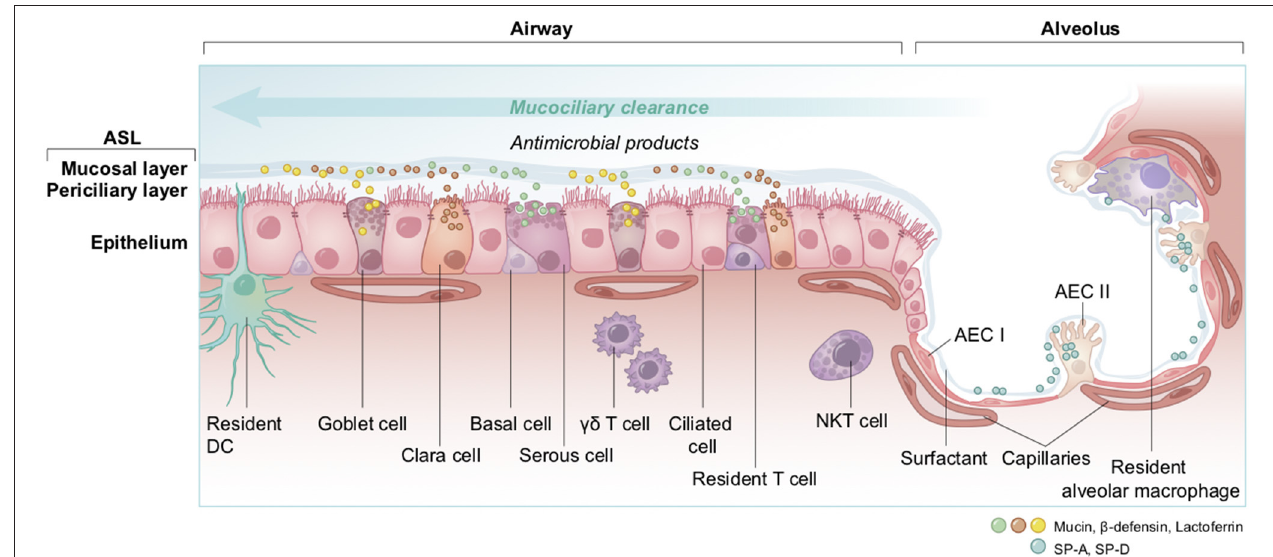
FIGURE 13 | Overview of cell types and innate immunity in the epithelium of the lung. The airway epithelium is a pseudostratified columnar epithelium involved in air conduction, lung moisture and protection. It lines the respiratory airways and is made up of different cell types. Basal cells serve as progenitor for other cells; goblet and serous cells produce and secrete antimicrobials and mucins as part of the airway surface liquid (ASL, composed of a periciliary layer and a more viscous upper mucosal layer); clara cells, with short microvilli, secrete defensive surfactants; and ciliated cells which act in mucociliary clearance. At the endpoint of the respiratory system, the alveolar epithelium that lines alveoli is a thin simple squamous epithelium made up of two cell types; AEC I are flattened squamous cells covering 95% of the surface, in close interaction with the capillaries to facilitate gas exchanges; and AEC II which are cuboidal cells producing and secreting the surfactants. Additionally, to ensure the host protection, many immune cells are resident; the DC, with their snorkels-shaped extension across epithelial tight junctions act as phagocytes and antigen presenting cells in contact with antigens; T cells, γδ T, and NKT cells are characterized by a rapid production and secretion of cytokines upon interactions with pathogens; and alveolar macrophages which are sentinel phagocytes in close proximity with AEC I and II in the alveoli. DC, dendritic cell; NKT, natural killer T cell; γδ T, gamma delta T cell; AEC I and AEC II, alveolar epithelial cells; SP-A, SP-D, surfactant protein A and D.